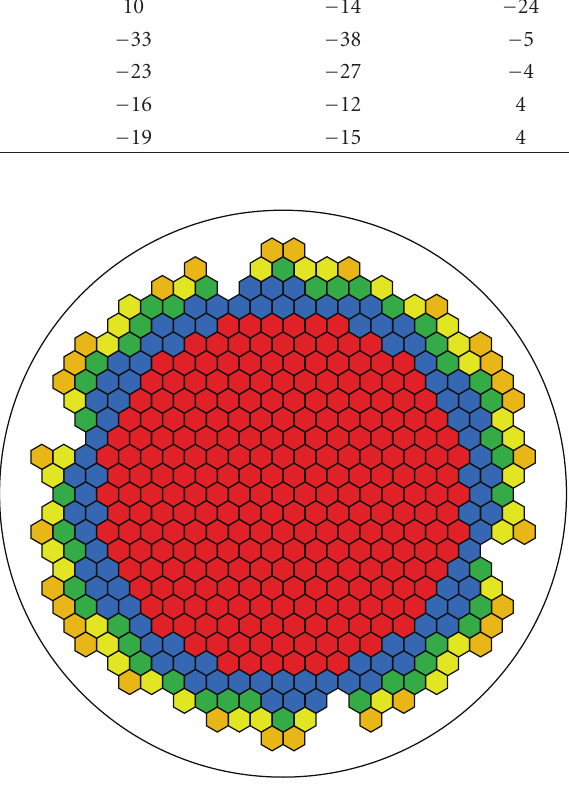
Figure 15: Illustration of radial mapping to